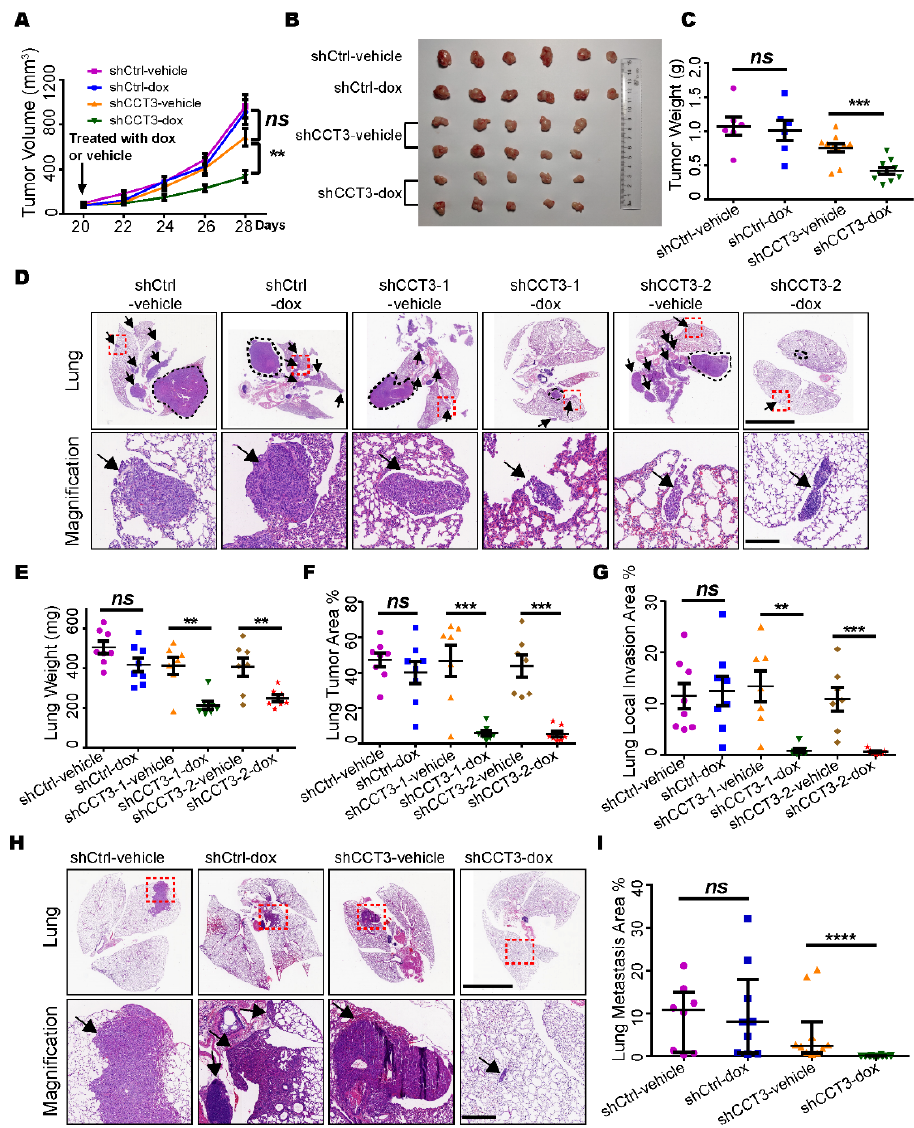
Figure 2. Silencing CCT3 inhibits the tumor growth and lung metastasis of LUAD. ( A ) Tumor growth in the subcutaneous tumor model. When the tumor volume reached 100 mm 3 , the mice were administrated with dox or vehicle, as indicated, to induce the knockdown of CCT3 in tumor cells. N = 6 or 10/group. ( B ) Tumors resected from each group ( A ). ( C ) Final tumor weight in each group ( A ). ( D ) Orthotopic tumor model. Representative H&E images of the lungs inoculated with different cell-line groups (n = 7 or 8/group) treated with dox or vehicle as indicated. The black dotted lines mark the primary tumors. The black arrows indicate the lung local invasion of tumor cells. The red dashed boxes indicate the amplified positions. The scale bar of upper lung images is 5 mm, and the scale bar of bottom amplified views is 200 μ m. ( E – G ) Lung wet weight ( E ), lung tumor area ( F ) and lung local invasion area ( G ) were quantitated in the orthotopic tumor model ( D ). ( H ) Lung metas- tasis in mice after intravenous injection with tumor cells treated as indicated in the different groups (n ≥ 8/group). The red dashed line boxes indicate the amplified positions, the black arrows indicate the metastasis tumor. The scale bar of upper lung images is 5 mm, and the scale bar of bottom am- plified views is 200 μ m. ( I ) Quantification of lung metastasis areas. Dox, 2 mg/mL doxycycline in 5% sucrose water; vehicle, 5% sucrose water. Data are represented as mean ± SEM or median with interquartile range; ns, not significant; ** p < 0.01, *** p < 0.001, **** p < 0.0001, Mann–Whitney or two-tailed Student’s t -tests.